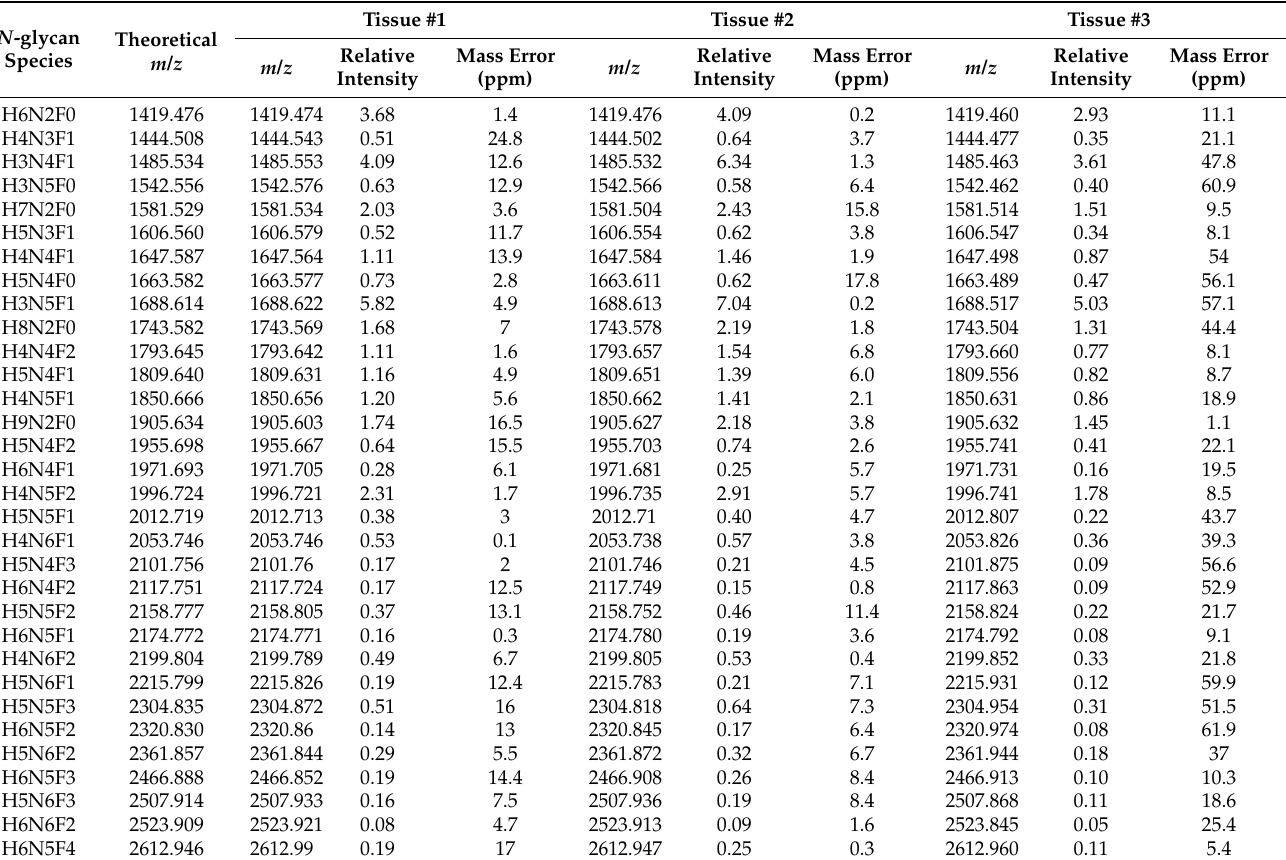
Table 1. Common N -glycans detected in human glioblastoma cell-derived xenografts ( n =